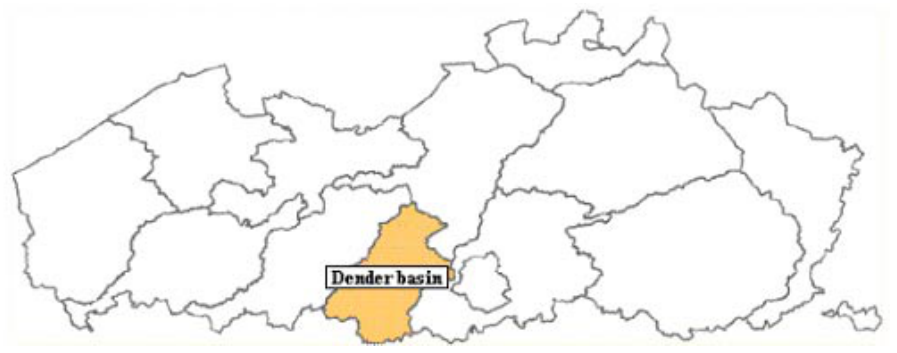
FIGURE 1. The Dender River basin in